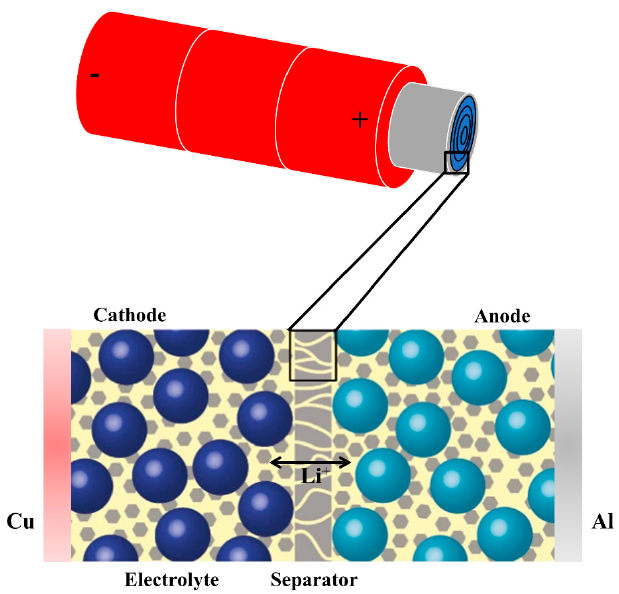
Table 1. General requirements for separators used in Li-ion batteries [8].